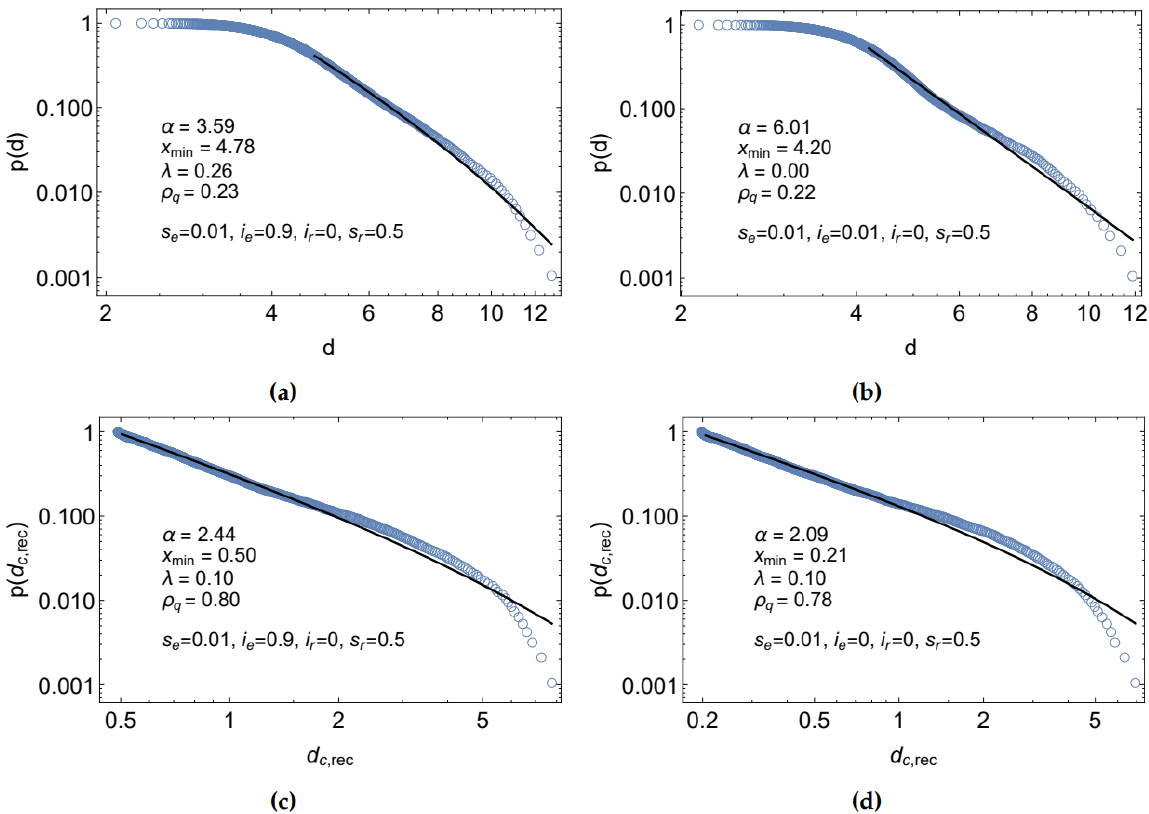
Figure 4. Log-log scale plots of the degree d (top) and the critical degree d c , rec (bottom) distributions in CCM. The black lines represent the corresponding truncated power law fits. The insets show the fit parameters as well as the scenario configurations. The plots (a) and (b) differ by the scenario configurations shown in the insets; similarly for (c) and (d). These scenarios are among the top five swarm performances with respect to N coll . Please note that λ x min is relatively small, i.e., power law is a good fit for x close to x min . See Supplementary Material Section3 for plots of d in CCM over all 256 scenario